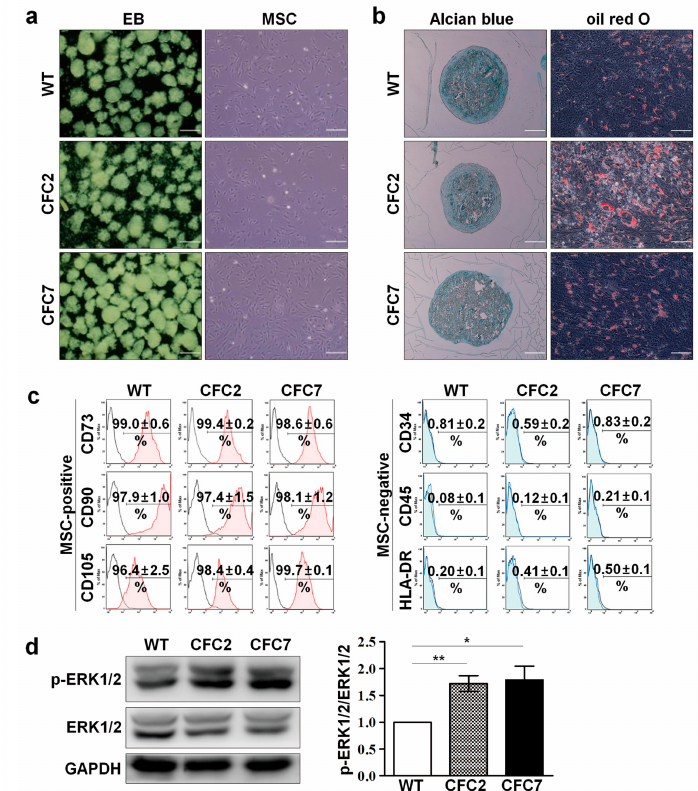
Figure 1. Induction of iPSCs into MSCs. ( a ) Normal differentiation of EBs and MSCs developed from CFC-iPSCs. WT- and CFC-derived EBs (left panel) and MSCs (right panel) had a normal morphology. Scale bars, 200 µ m; ( b ) Differentiation of CFC-MSCs into chondroblasts (alcian blue staining, left panel) and adipocytes (oil red O staining, right panel). Scale bars, 500 µ m (left panel) and 50 µ m (right panel); ( c ) Expression profiles of MSC-positive and -negative surface markers; ( d ) Increased p-ERK1/2 level in CFC-MSCs compared to WT-MSCs. The band intensity of CFC-MSCs was measured using Image J, normalized to that of GAPDH, and expressed as fold changes relative to that of WT-MSCs. Data were described as the mean ± SEM (n = 3, biological replicate). * p < 0.05, ** p <